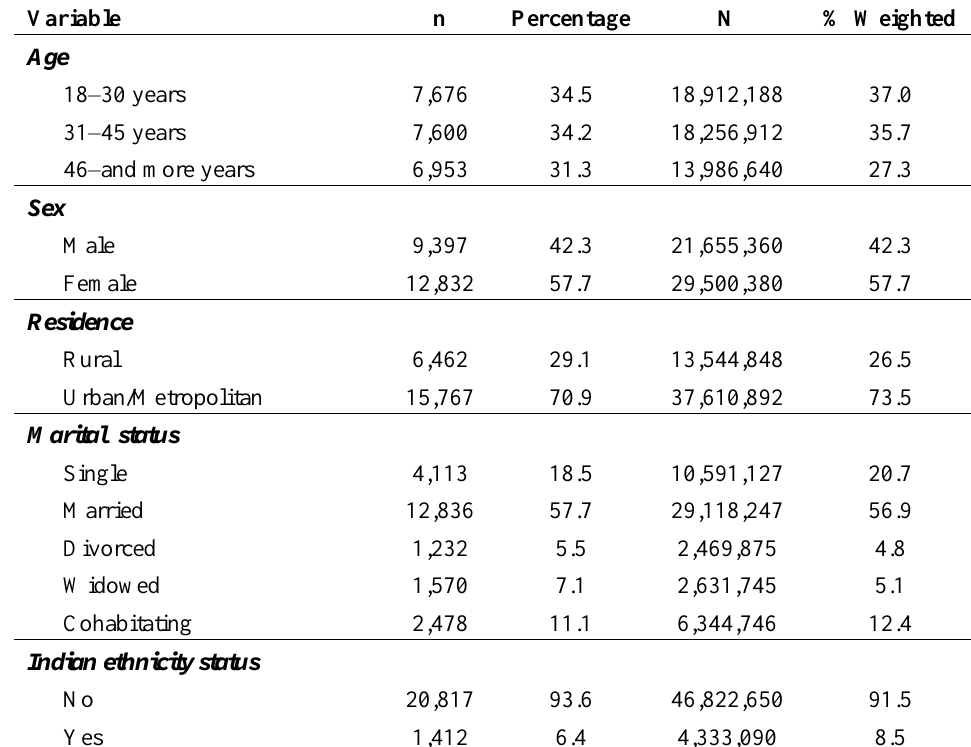
Table 1. Descriptive characteristics of the study population and prevalence of self-reported oral and dental problems (estimated national population N =